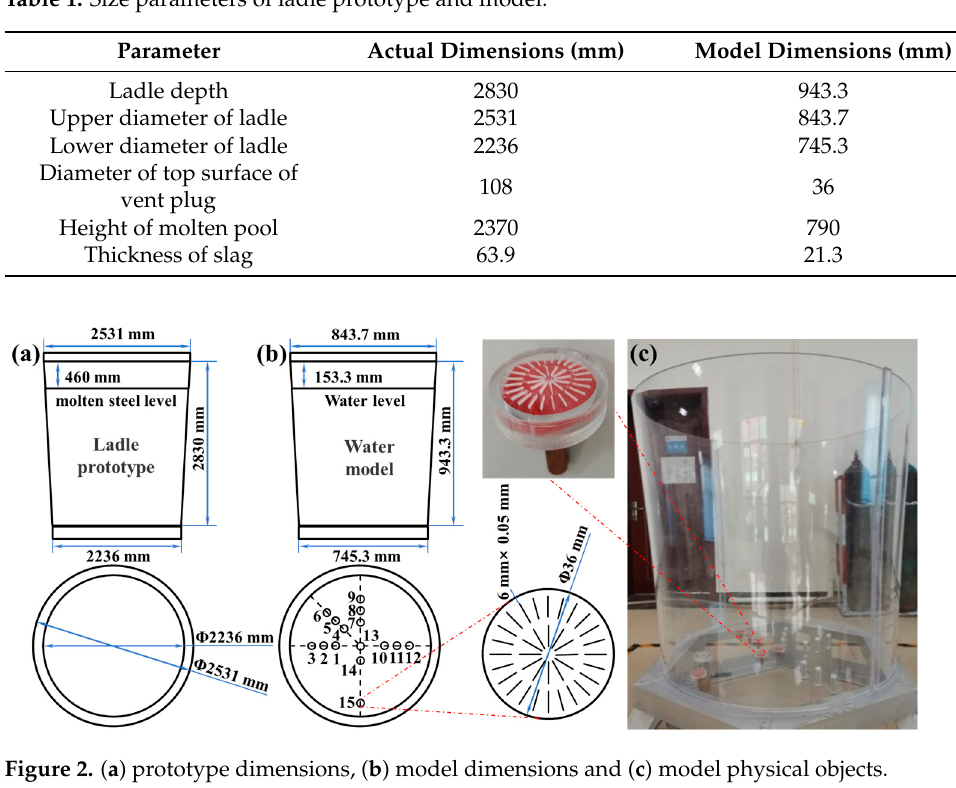
Figure 1. Schematic diagram of water model experimental equipment. Table 1. Size parameters of ladle prototype and model.